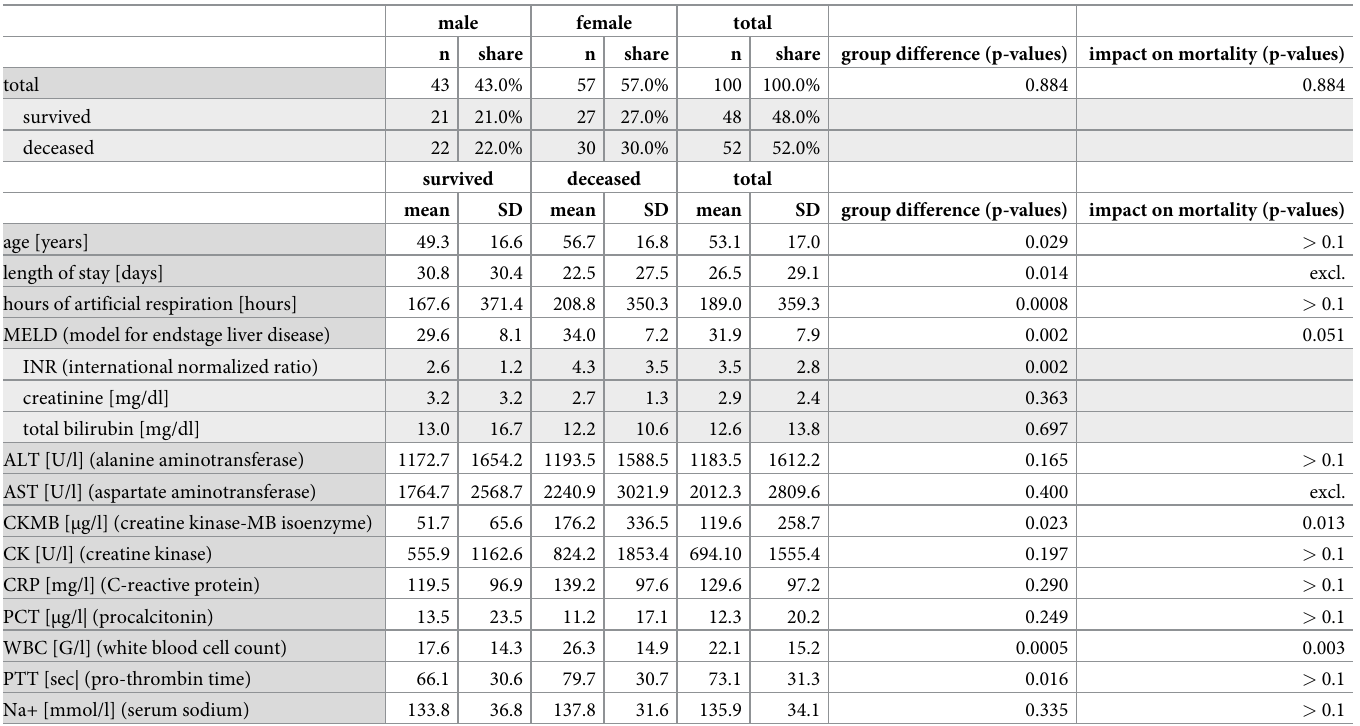
Table 1. Baseline demographics and laboratory values.